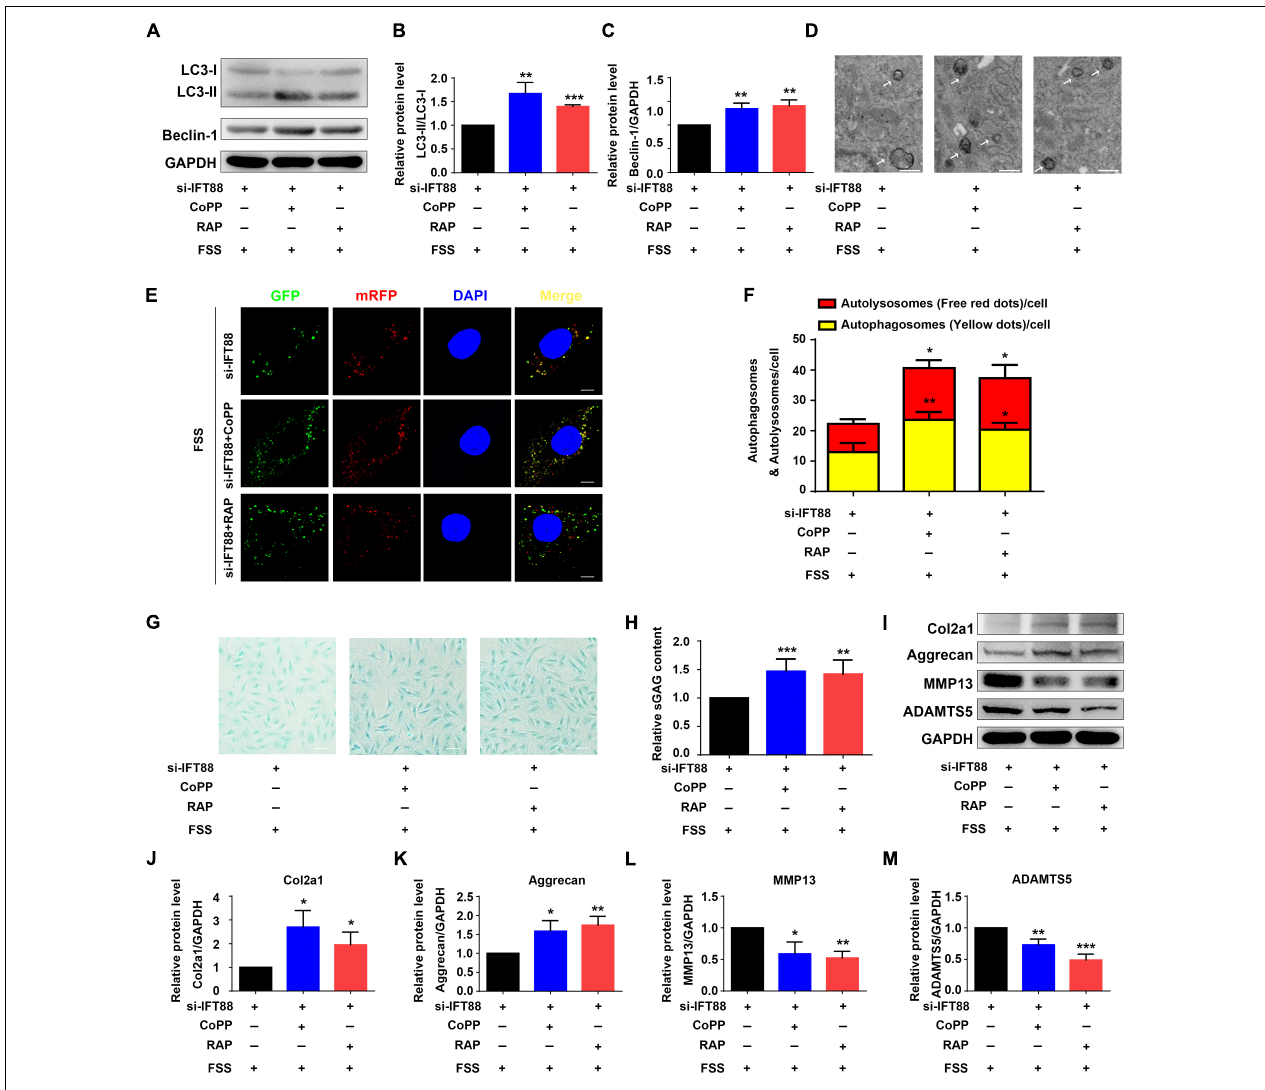
FIGURE 7 | HO-1 upregulation or rapamycin reverses IFT88 loss-induced alterations in autophagy and ECM production in FSS-treated NP cells. (A–C) Western blotting. NP cells were transfected with IFT88-siRNA. Then, cells were pretreated with CoPP (10 µ M) or rapamycin (RAP, 500 nM) and subjected to 12 dyne/cm 2 FSS for 2 h, followed by western blotting for expression of LC3-I, LC3-II, and Beclin-1 (A) . Quantification of LC3-I/LC3-II ratio and Beclin-1 from three independent experiments (B,C) . (D) Transmission Electron Microscopy (TEM). NP cells were treated as in panel (A) . TEM images are shown. The arrows indicate double-membrane autophagosomes and autolysosomes. Bar, 500 nm. (E,F) Measurements of autophagosomes and autolysosomes. NP cells were transduced with lentivirus expressing a tandem mRFP-GFP-LC3 construct and treated as in panel (A) . Fluorescence images were obtained. Bar, 5 µ m. Quantification of autophagosomes (yellow dots) and autolysosomes (free red dots) from three independent experiments (F) . (G,H) sGAG content. NP cells were treated as in panel (A) , followed by alcian blue staining (G) and Blyscan Sulfated Glycosaminoglycan Assay (H) . Bar, 100 µ m. (I–M) Western blotting. NP cells were treated as in panel (A) , followed by western blotting for expression of the indicated proteins (I) . Quantification of expression of Col2a1, aggrecan, MMP13 and ADAMTS5 from three independent experiments (J–M) . Results are expressed as mean ± standard deviation (s.d). * P < 0.05, ** P < 0.01, and *** P < 0.001 vs. FSS + IFT88-siRNA